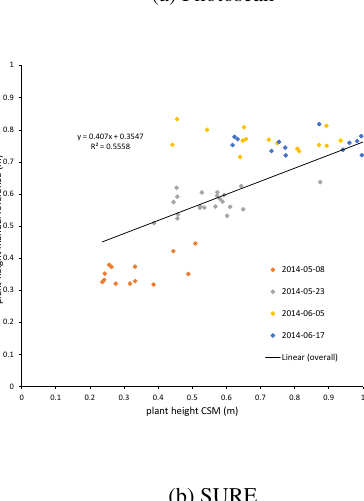
Figure 5. Top-down view of point cloud for the morning of May 08 generated by VisualSFM and CMVS/PMVS2